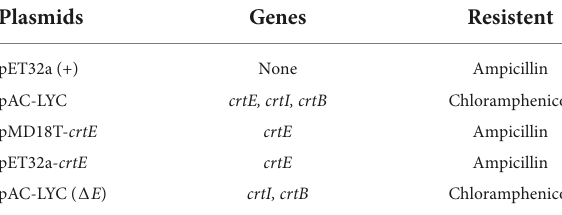
TABLE 2 Plasmids used in this study and their main